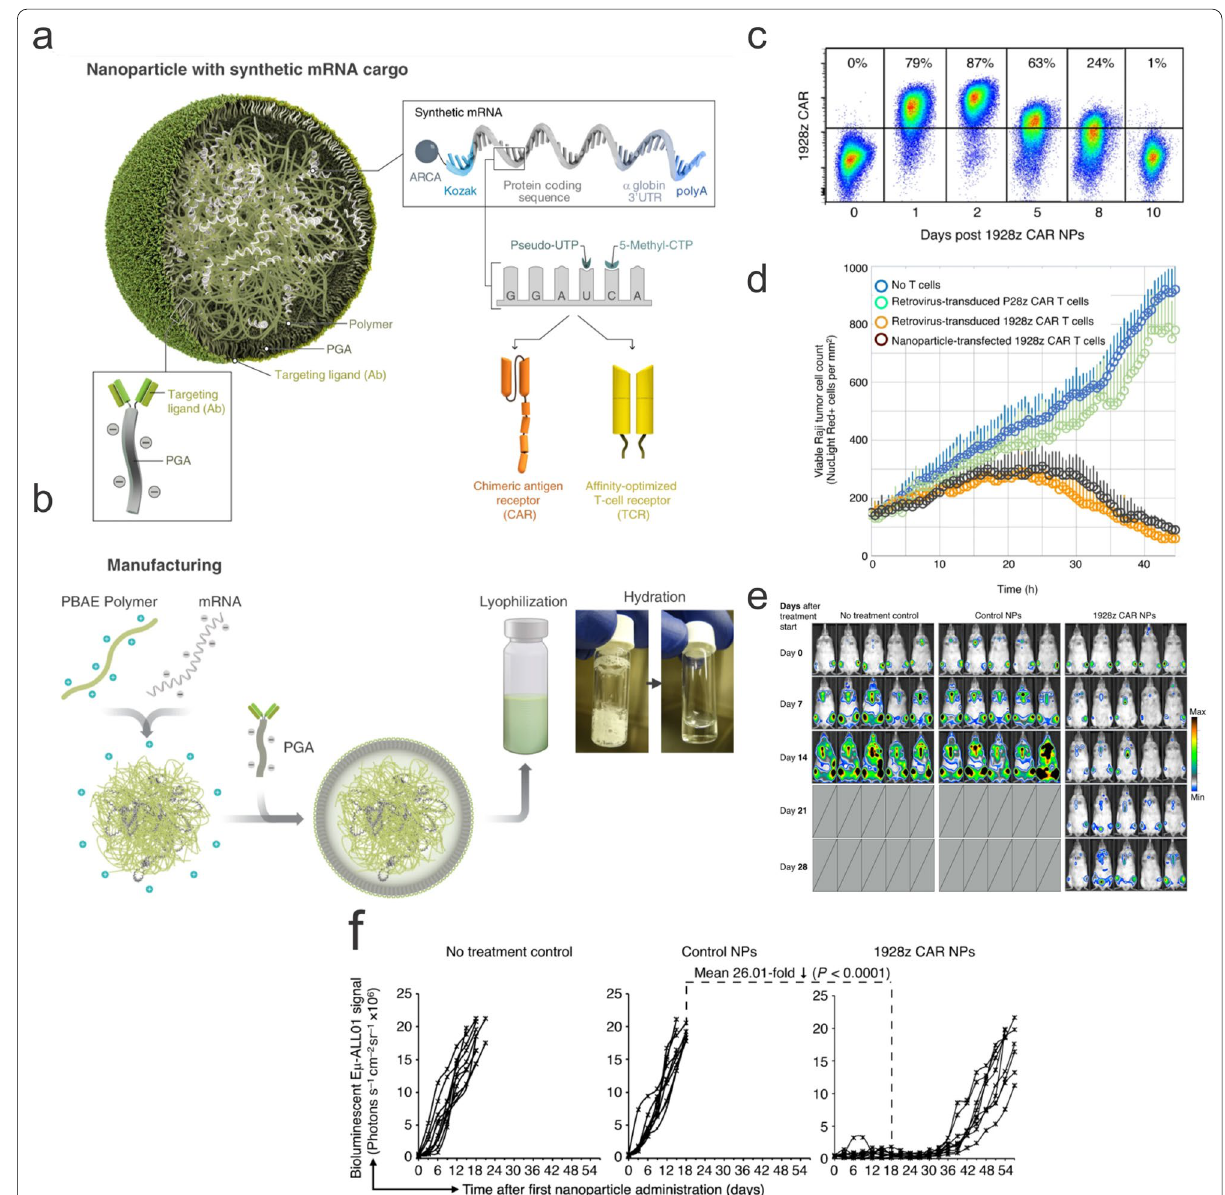
Fig. 5 Polymeric nanocarrier for the delivery of CAR IVT mRNA into T cells. a Schematic illustration of the PBAE nanocarrier encapsulating the IRF5 and IKK IVT mRNA. The polymeric nanoparticles created from self‑assembly could be readily lyophilized and redispersed, increasing flexibility for storage and transport. c Transfection efficiencies of the nanocarriers into T cells. d The nanoparticle‑reprogrammed T cells showed comparable lysis activity to lentivirus‑transduced T cells against Raji lymphoma cells. e Only the transfected T cells were able to alleviate tumor burden and f extend average survival time in C57BL/6 mice. Reproduced with permission from ref